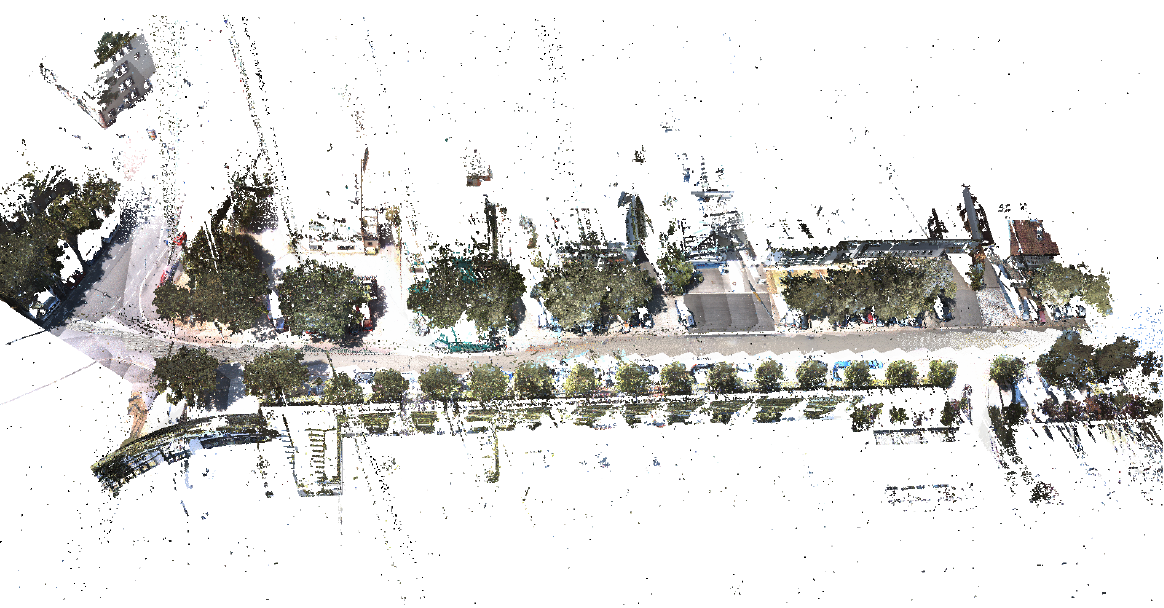
Figure 4. Point cloud: acquired by mobile mapping system, used for